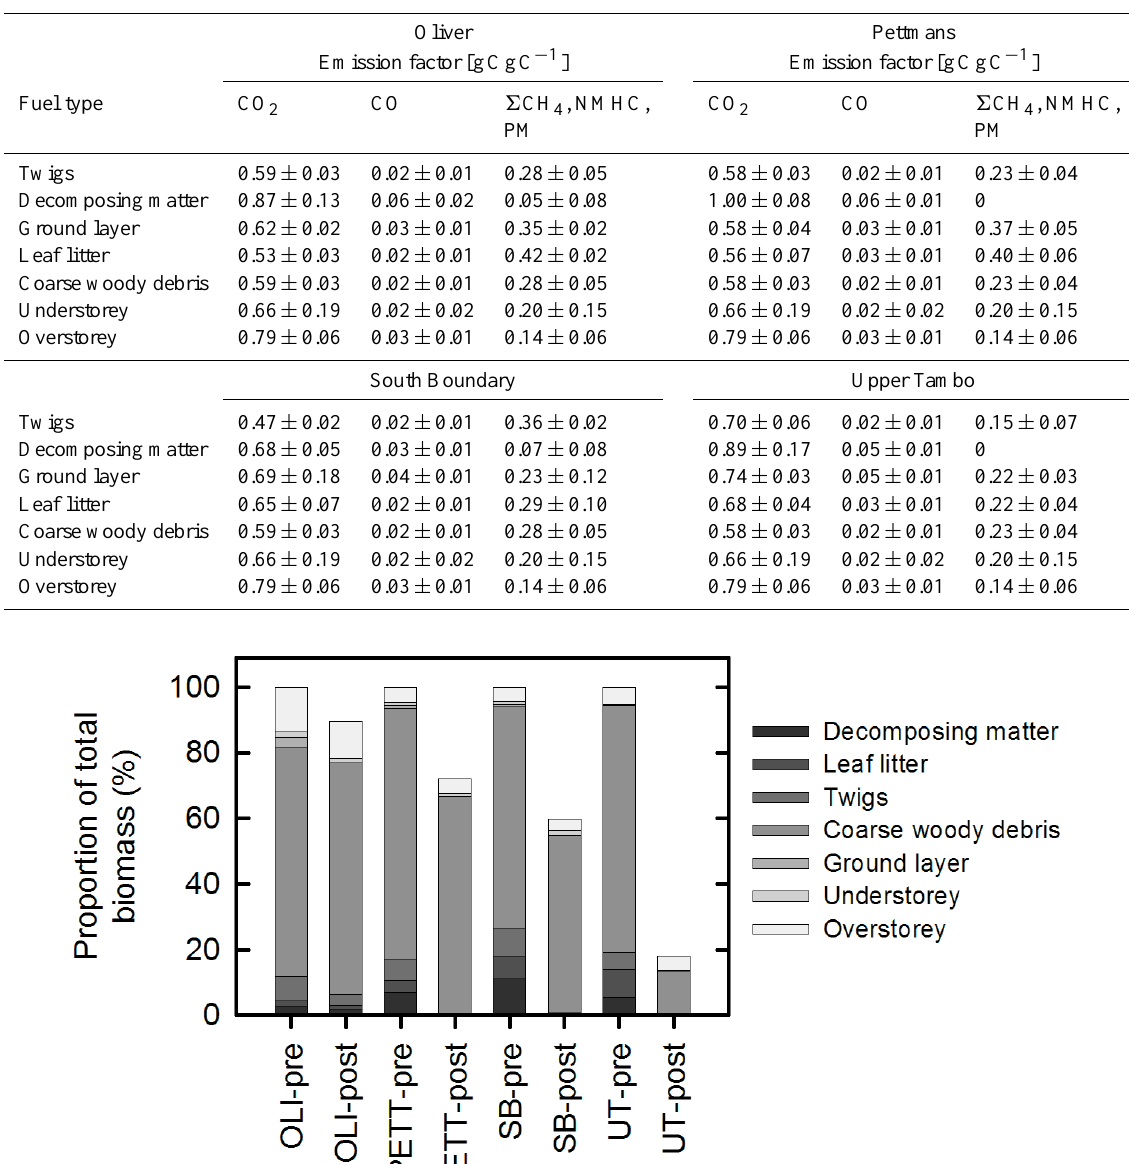
Table 4. Emissions factors for CO 2 , CO and pooled CH 4 , volatile organic compounds (VOC) and particulate matter (PM) for different fuel types from forest sites in East Gippsland, south-eastern Australia, that were combusted in a mass-loss calorimeter. Coarse woody debris was assumed to have the same values as twigs. Values are mean ± standard deviation ( n = 3).